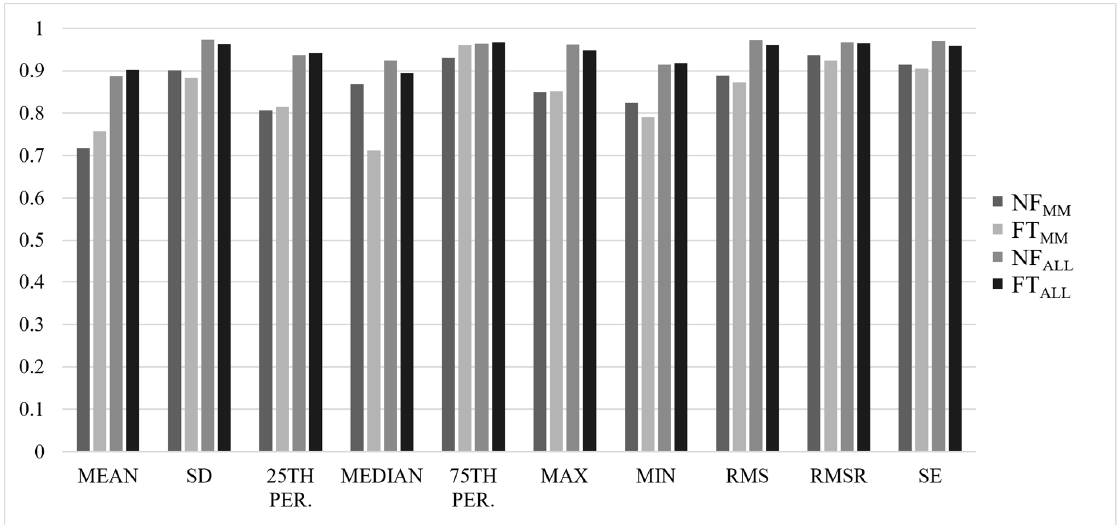
Figure 1. ICC(2,k) values for all analyses in the vertical (VT) axis of the acceleration signal. MM = comparison performed between first (MLSS1) and second (MLSS2) trials at MLSS speed, ALL = comparison performed between all four trials; NF = non-fatigued state, FT = fatigued state, SD = standard deviation, RMS = root mean square, RMSR = ratio of root mean square, SE = sample